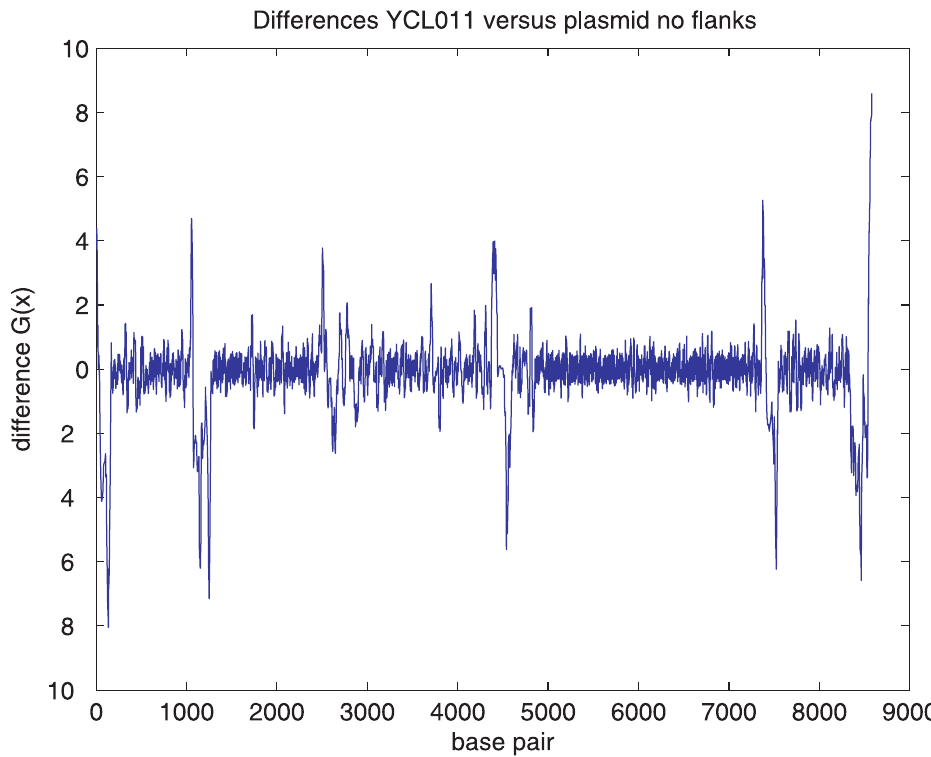
Figure 2. The difference profile of the YCL011 construct plasmid region is shown. This is the difference between the G ( x ) energy values for that construct and those for the plasmid alone, with no flanking region.